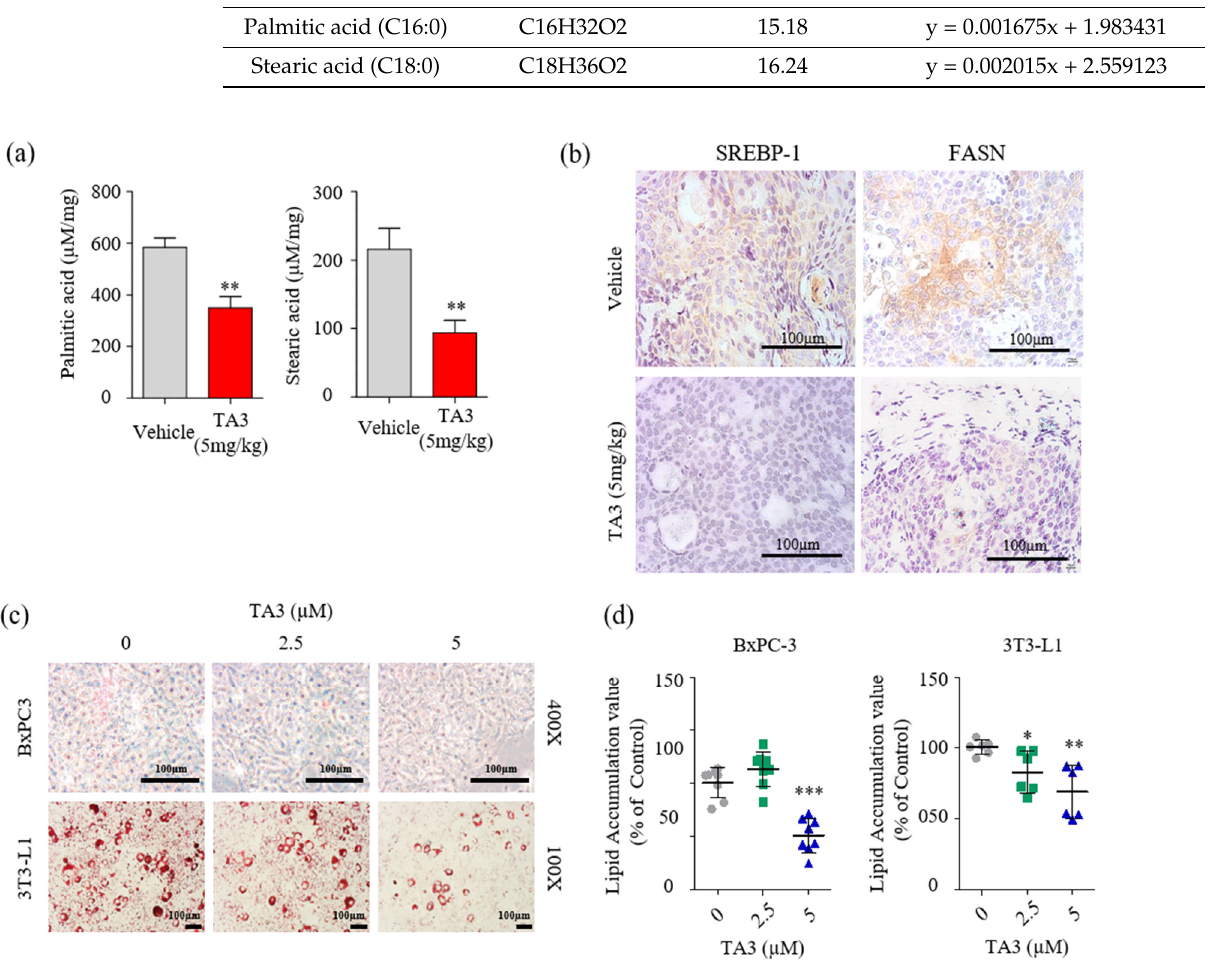
Table 3. Calibration curve of palmitic acid and stearic acid standards using LC/MS. Compounds